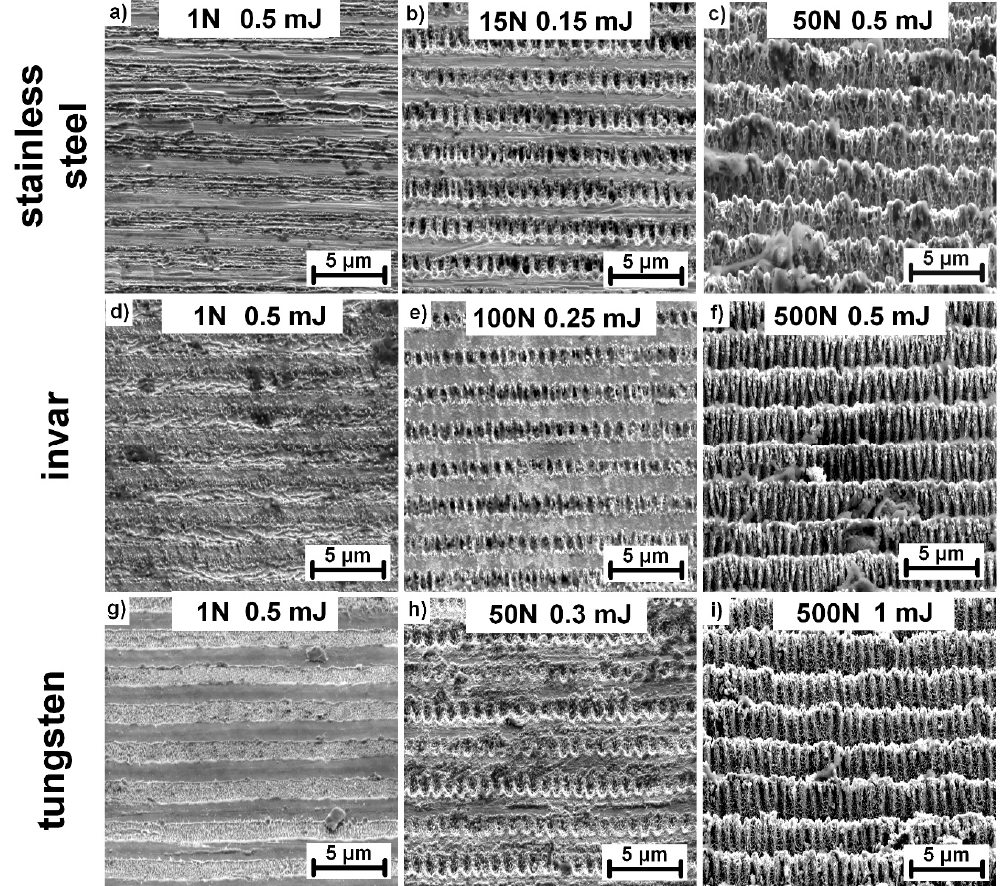
Figure 6. Different surface morphologies achieved by variations in the pulse energy and number of pulses (N) on invar ( a – c ), stainless steel ( d – f ), and tungsten ( g – i ). All images were captured with the pulses (N) on invar ( a–c ), stainless steel ( d–f ), and tungsten ( g–i ). All images were captured with the sample tilted 55°. sample tilted 55 ◦ .